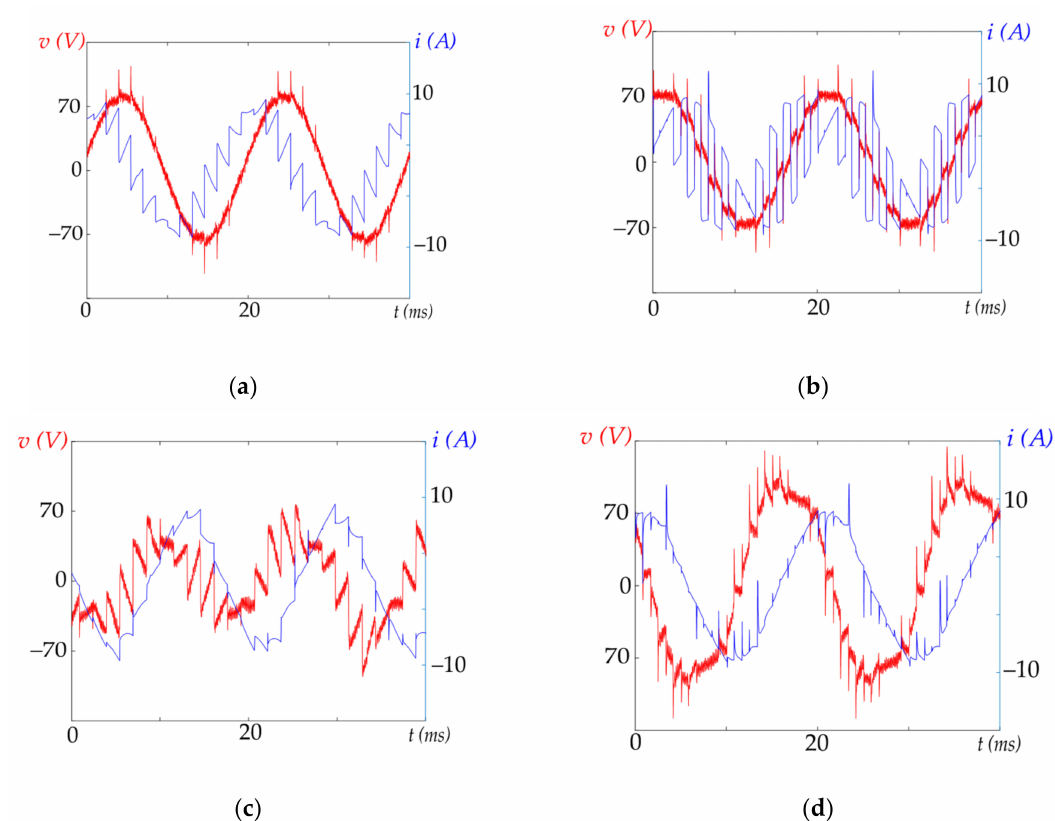
Figure 16. The results from the real-life laboratory model for the 6 × 6 MMC structure with a 20 ◦ shift introduced. Voltage (blue) and current (red): ( a ) “crossing point” approach input values; ( b ) “as close as possible” approach input values; ( c ) “two closest” approach output values; ( d ) “as close as possible” approach output